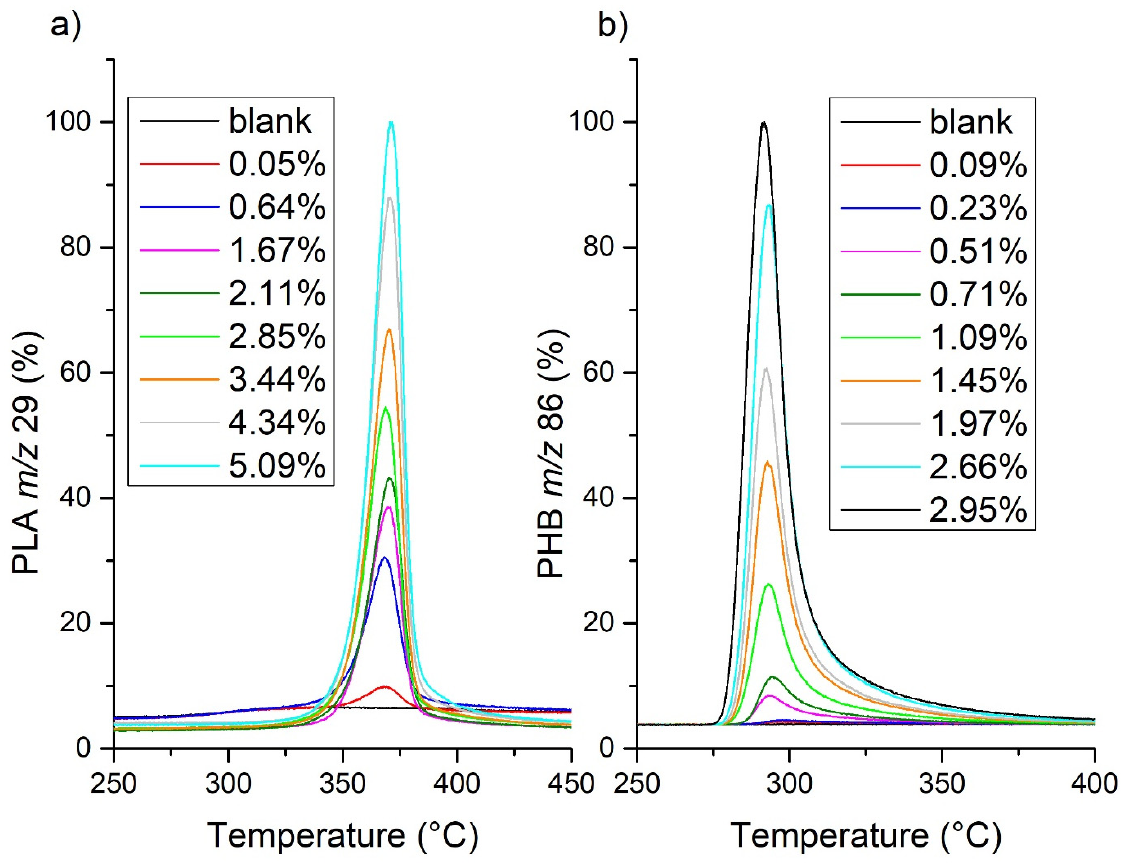
Figure 3. Example PLA ( a ) calibration mixture peaks for soil P185 and m / z 29 and PHB ( b ) calibration mixture peaks for soil HS5 and m / z 86.